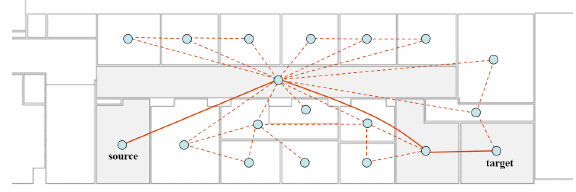
Figure 3. Inter-space path between a source and a target (image taken from Whiting, E. J.